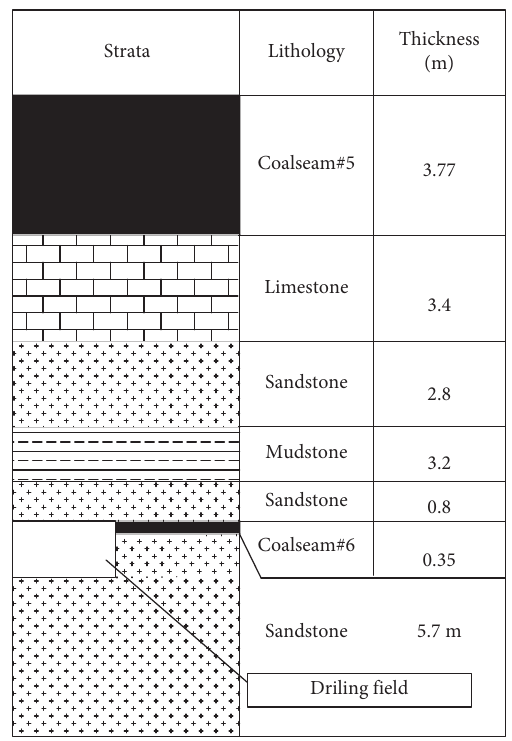
Figure 4: Stratigraphic column and position of the bed floor tunnel. Table 2: Mechanical parameters of the surrounding rock of the drilling field.